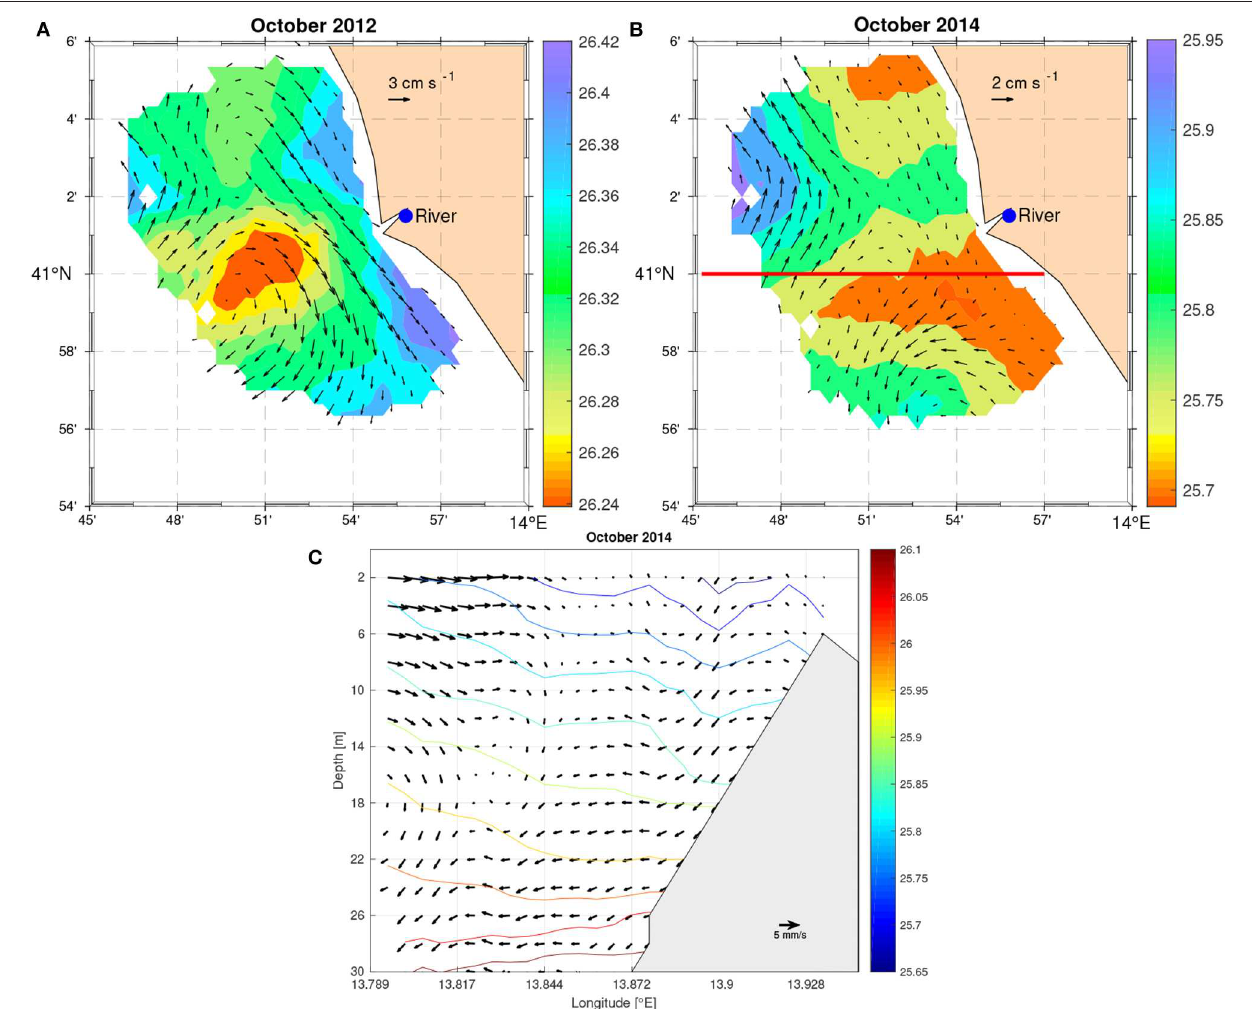
FIGURE 12 | Density and steady circulation at 5 m from the diagnostic numerical experiment using temperature and salinity fields optimally interpolated from the CTDs of October 2012 (A) and in October 2014 (B) . Units are kg m − 3 for density ( σ t ) and cm s − 1 for the total velocity, which are not plotted where the expected error of the OA on the observed temperature and salinity exceeds 20 % . Panel (C) shows the vertical velocities and the density contours at 41 ◦ N (red line in B